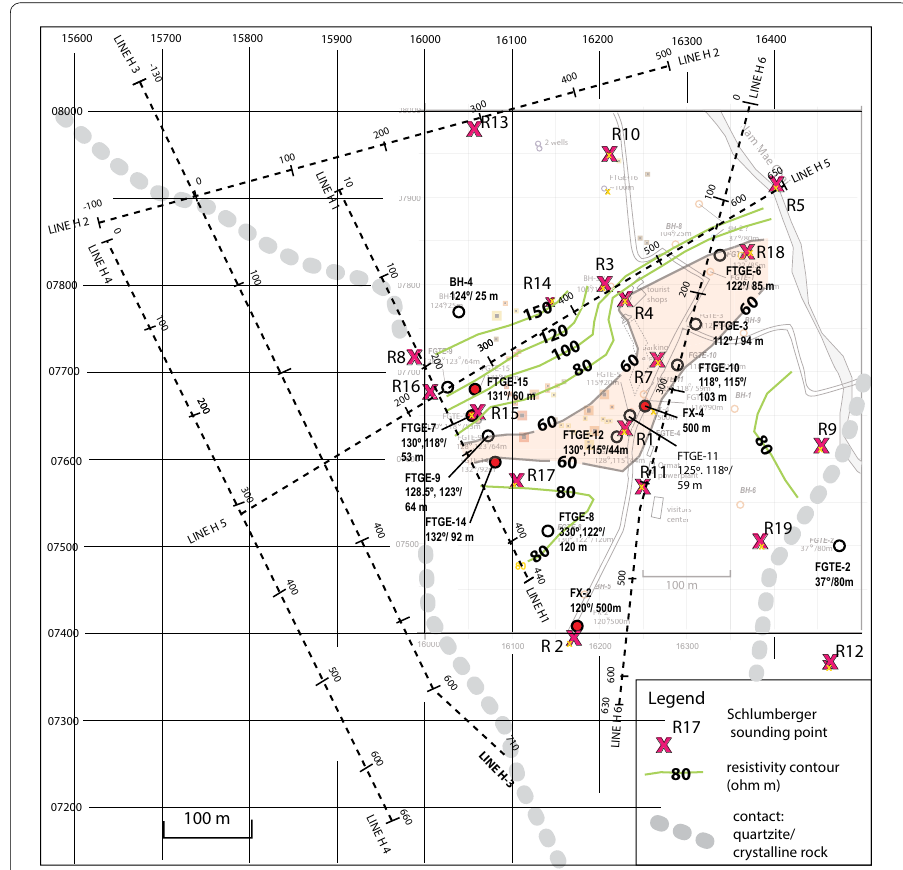
Fig. 18 Map showing Schlumberger sounding points of Fig. 19, locations of lateral DC resistivity profiles H1, H5, H6 (shown on Fig. 20), and contoured anomalously low apparent resistivity ( AB /2 Coothungkul and Chinapongsanond (1985)